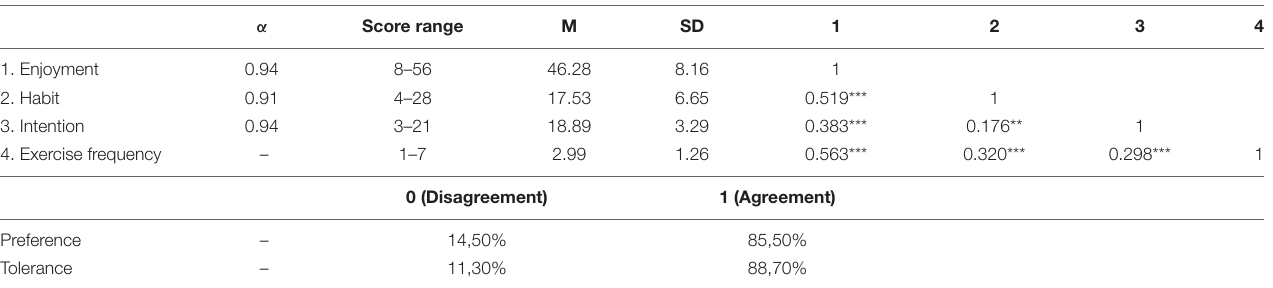
TABLE 1 | Descriptive, reliability, and correlation analysis of studied